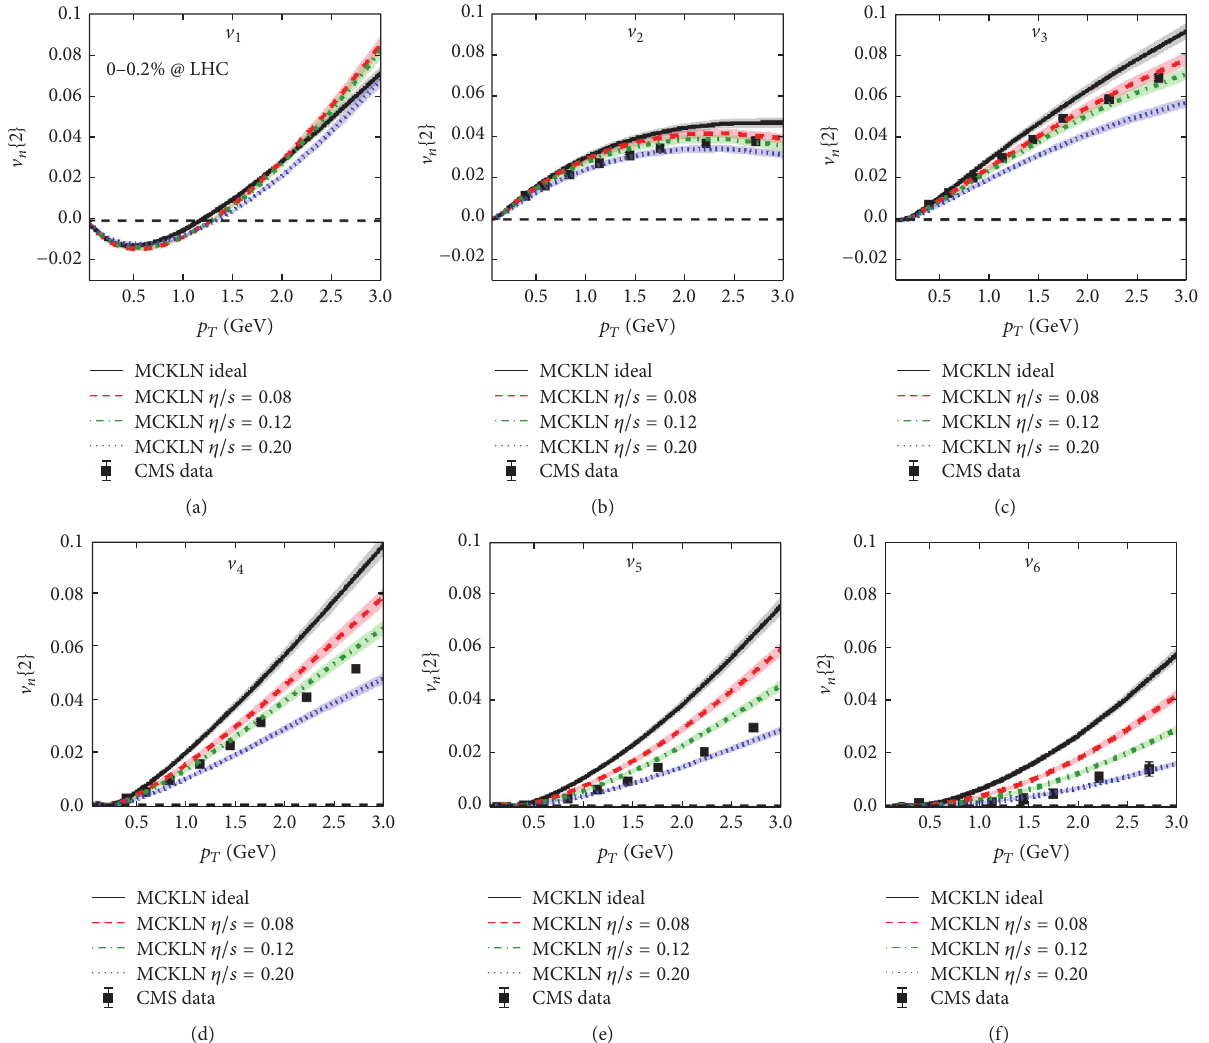
Figure 10: Comparison of 𝑝 𝑇 dependent V 𝑛 {2} of charged hadrons in 2.76 ATeV Pb+Pb collisions at 0–0.2% centrality for viscous hydrodynamics simulations (various lines) with the corresponding experimental results (solid squares); the figure is from